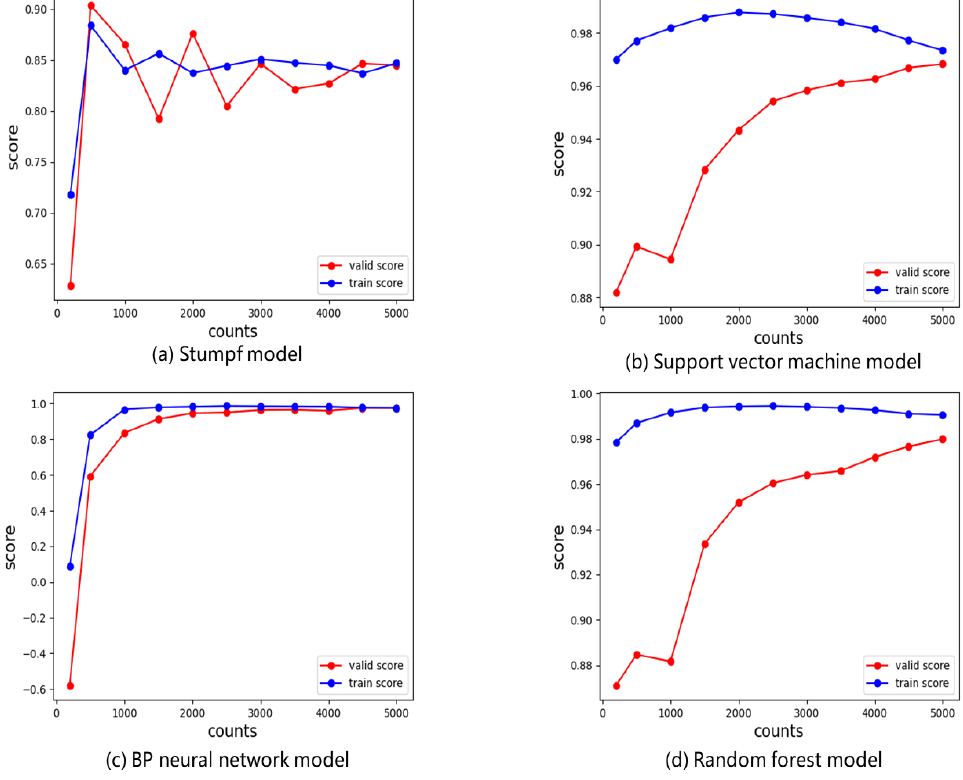
Figure 6. Model accuracy response to different numbers of samples.